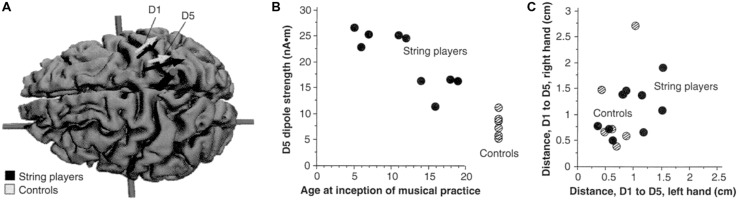
(A) Equivalent current dipoles elicited by stimulation of the thumb (D1) and fifth finger (D5) of the left hand are superimposed onto an magnetic resonance imaging (MRI) reconstruction of the cerebral cortex of a control, who was selected to provide anatomical landmarks for the interpretation of the MEG-based localization. The arrows represent the location and orientation of the ECD vector for each of the two digits’ averaged across musicians (black) and controls (shaded). The length of the arrows represents the mean magnitude of the dipole moment for the two digits in each group. The average locations of D5 and Dl are shifted medially for the string players compared to controls; the shift is larger for D5 than for Dl. The dipole moment is also larger for the musicians’ D5, as indicated by the greater magnitude of the upper arrow. (B) The magnitude of the dipole moment as a function of the age of inception of musical practice; string players are indicated by filled circles, control subjects by hatched circles. Note the larger dipole moment for individuals beginning musical practice before the age of 12. (C) Scatterplot of the Euclidean distances (in centimeters) between the cortical representations of Dl and D5. This distance for the musicians’ left hands was greater than that in controls, but this difference is not statistically significant. Reprinted from Elbert et al. (1995).